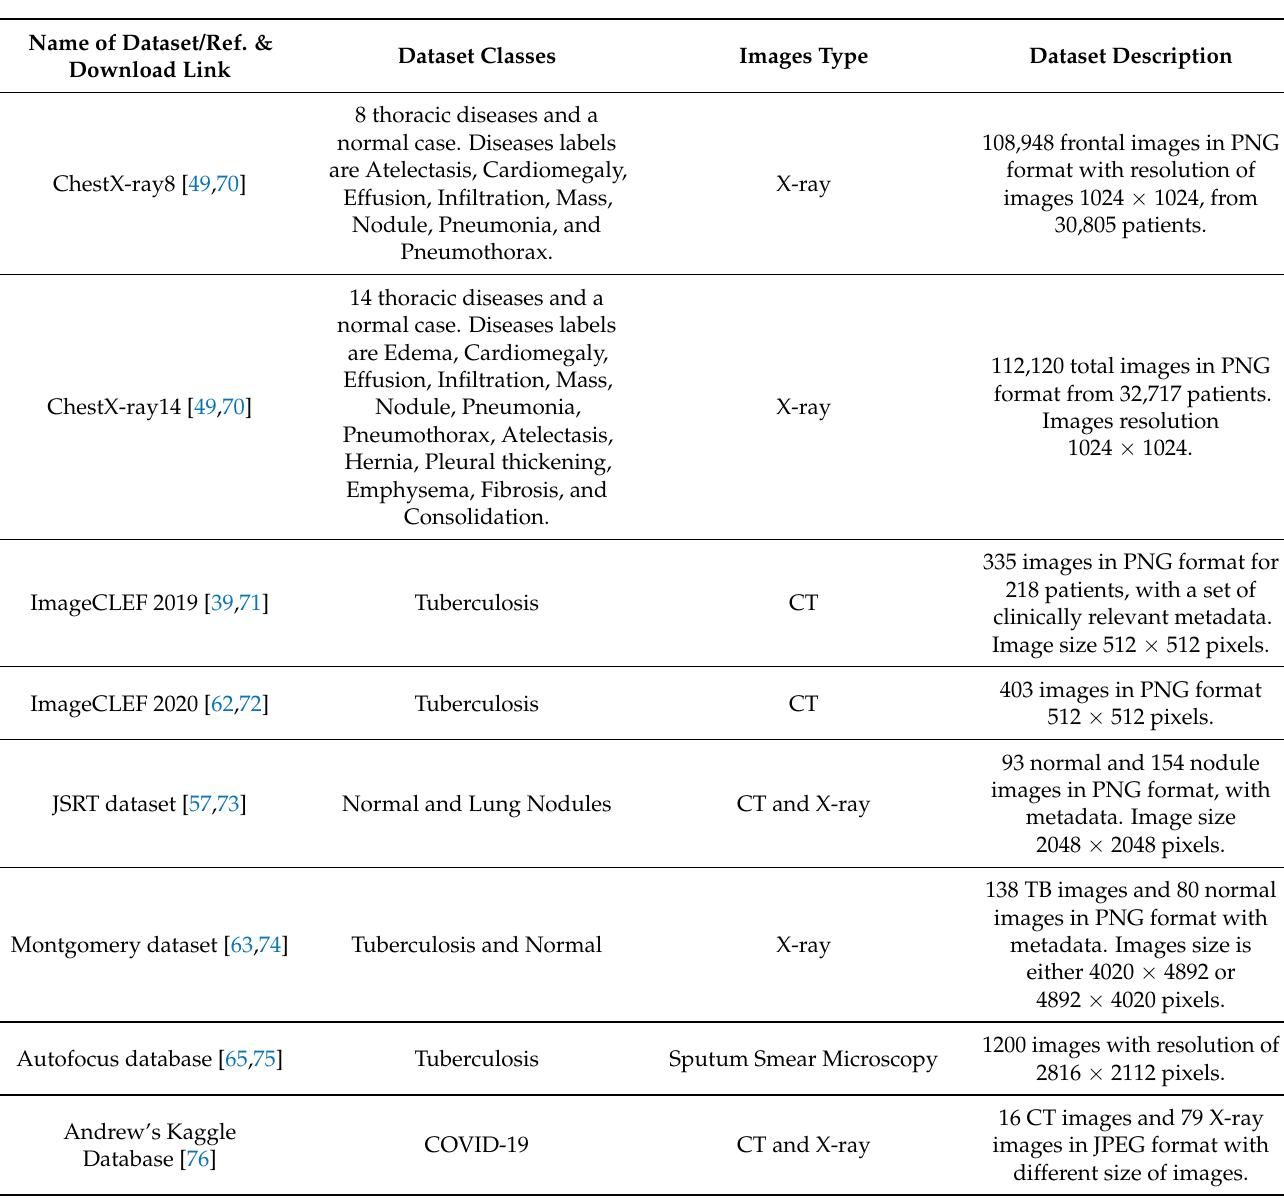
Table 2. Public datasets are used by contributions to deep learning applications in pulmonary medical imaging